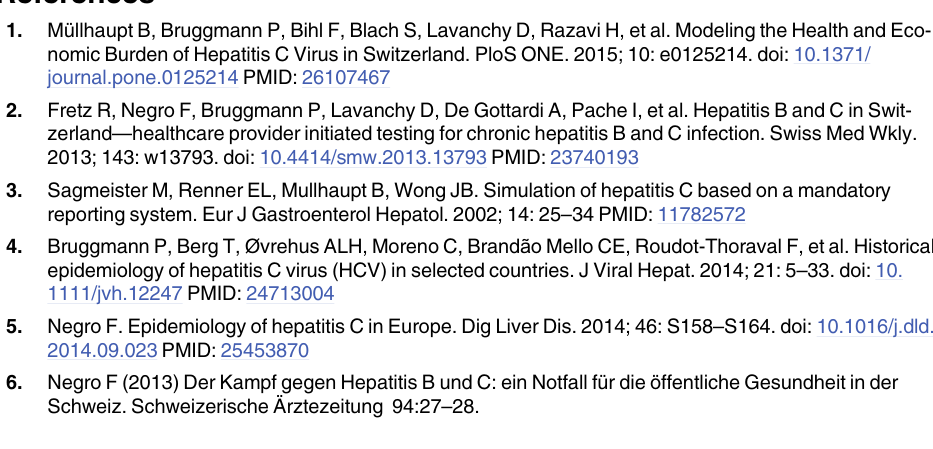
S1 Table. Data from the Swiss Hepatitis C Cohort Study used for this study. S2 Table. Data from the hepatitis C registry at the Federal Office of Public Health used for this study. S3 Table. Characteristics of included and excluded cases in the hepatitis C registry at the Federal Office of Public Health. S4 Table. Data from the Swiss Federal Statistical Office used for this study. S5 Table. SCCS and FOPH: all persons/cases by age group and country of birth/origin.